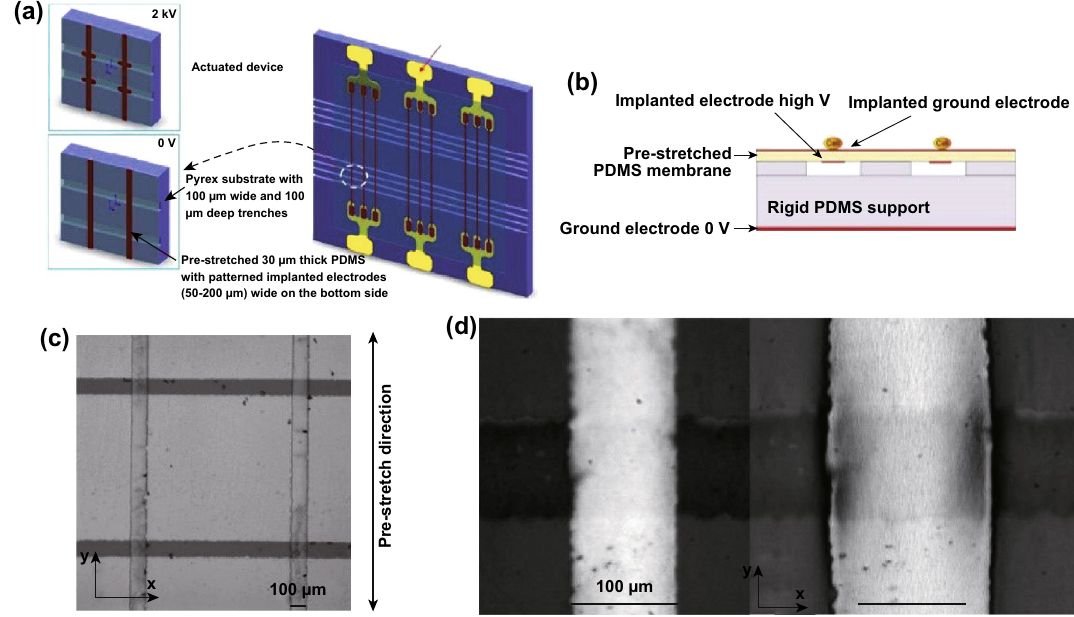
Fig. 5 The schematic of DEA designed for single-cell mechanical stretching. a , b The micro-actuator arrays are designed for single cell; each intersection of vertical lines and horizontal lines forms an individual actuator, where cells can be stretched. Adapted from Ref. [47] with permis- sion; c top view of a small part (four micro-actuators contained) obtained by microscope; the membrane is pre-stretched along y-axis. The bright lines aligned vertically are the ion-implanted electrodes on the top side of PDMS membrane, while the dark lines aligned horizontally are the bottom electrodes. Adapted from Ref. [46] with permission. d Micrograph of one actuator. Adapted from Ref. [84] with